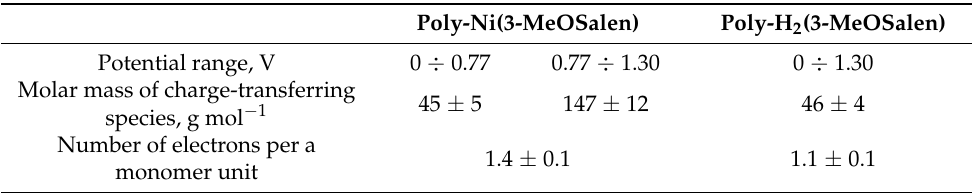
Table 2. Molar mass of charge-transferring species participating in the polymer oxidation/reduction process and the number of electrons per monomer unit exchanged during redox processes in the polymer